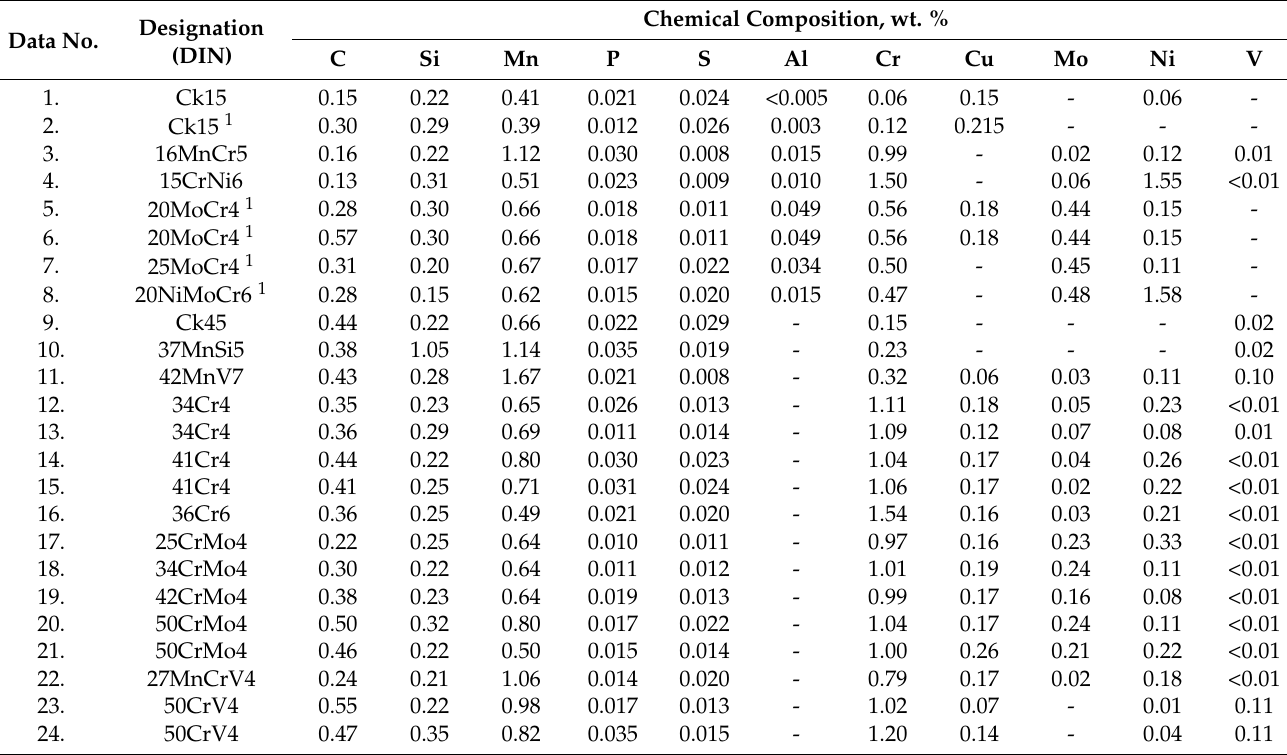
Table 1. Chemical composition of studied hypoeutectoid, low-alloy steels (balance Fe). Data No.